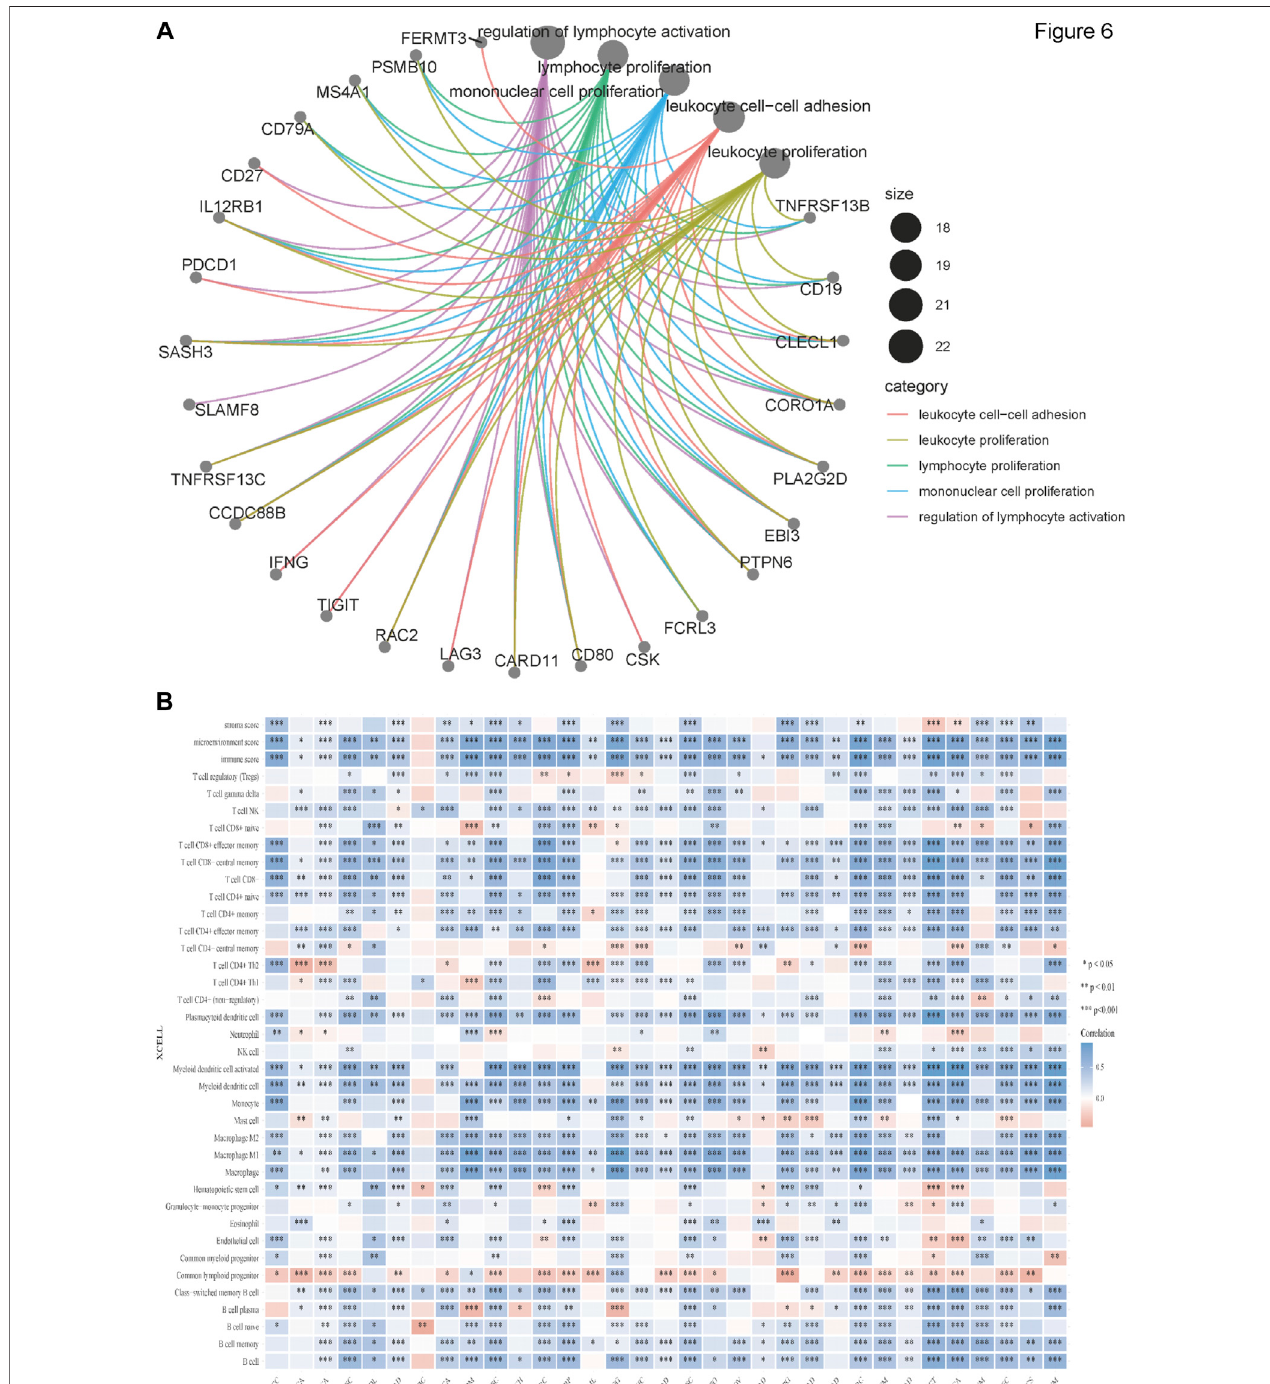
FIGURE6| Immune in fi ltrationofBATFinpan-cancer. (A) GOenrichment analysisofBATF. (B) Correlationbetween BATFexpression andimmune-cellin fi ltration.